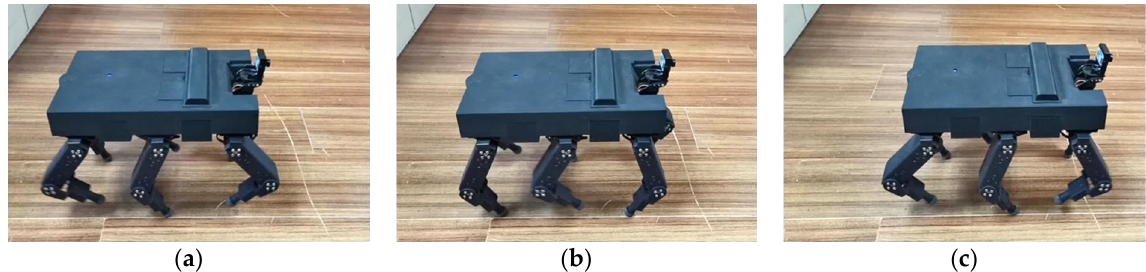
Figure 12. The experiment of HexWalker II walking forward using tripod gait: ( a ) Leg 2, leg 3, and leg 6 are swinging; ( b ) Leg 1, leg 4, and leg 5 are swinging; ( c ) Leg 2, leg 3, and leg 6 are swinging.